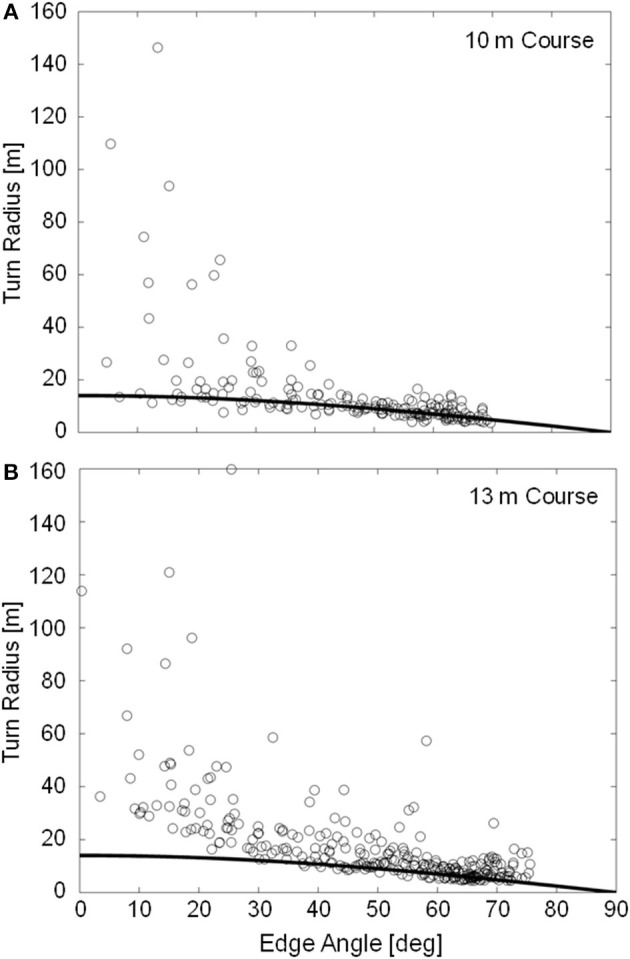
Instantaneous measured outside ski turn radius (RT, data points) and predicted outside ski turn radius using Equation 1 (RHOWE, data line) for the 12 analyzed trials on the 10 m (A) and 13 m (B) courses. Data are limited to time points where the ski was carving (ϕ < 5°, n = 185 and 298 for the 10 and 13 m courses, respectively).